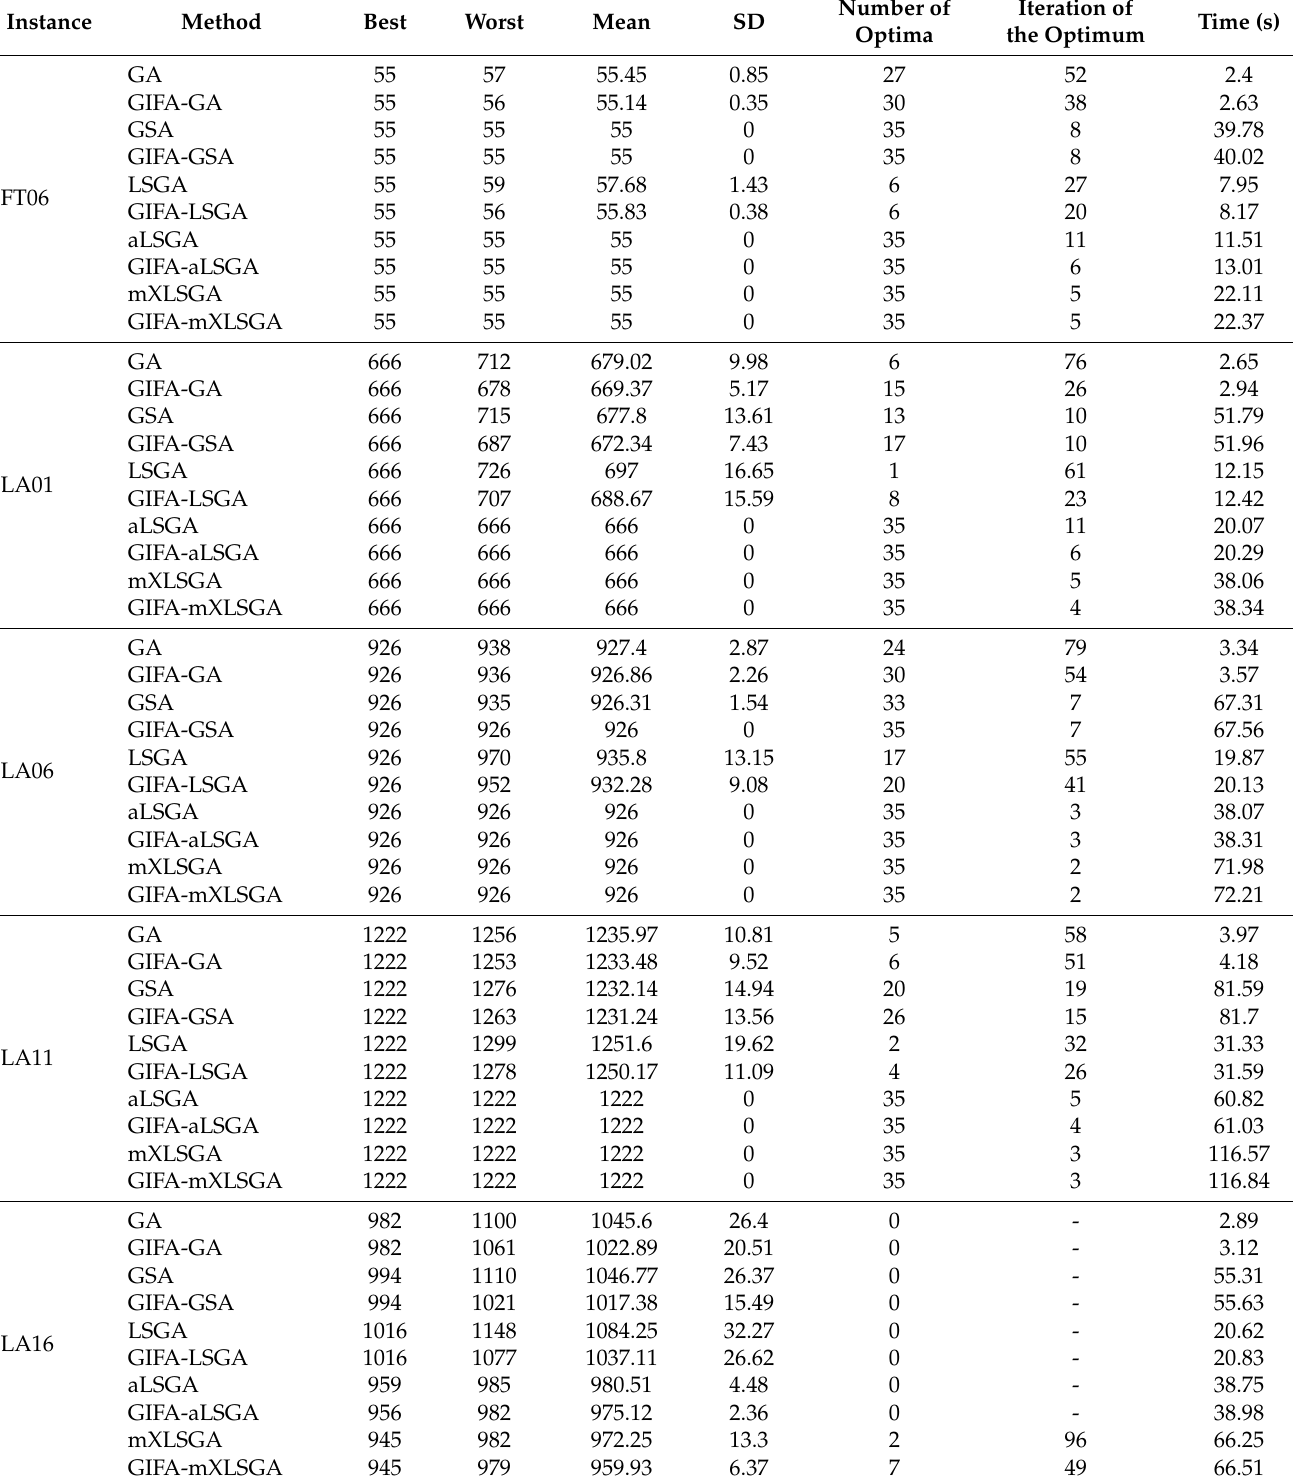
Table 1. GA-like methods statistics for 35 executions of each